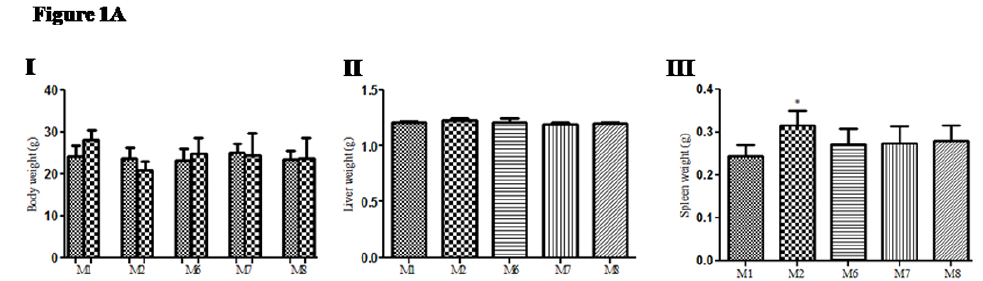
Fig. 1A. Therapeutic use of recombinant cytokines (IL-17A and IFN- γ ) after infection has no effect on change in body and organs weight of mice :(I) Change in body weight (II) Change in liver weight (III) Change in spleen weight.